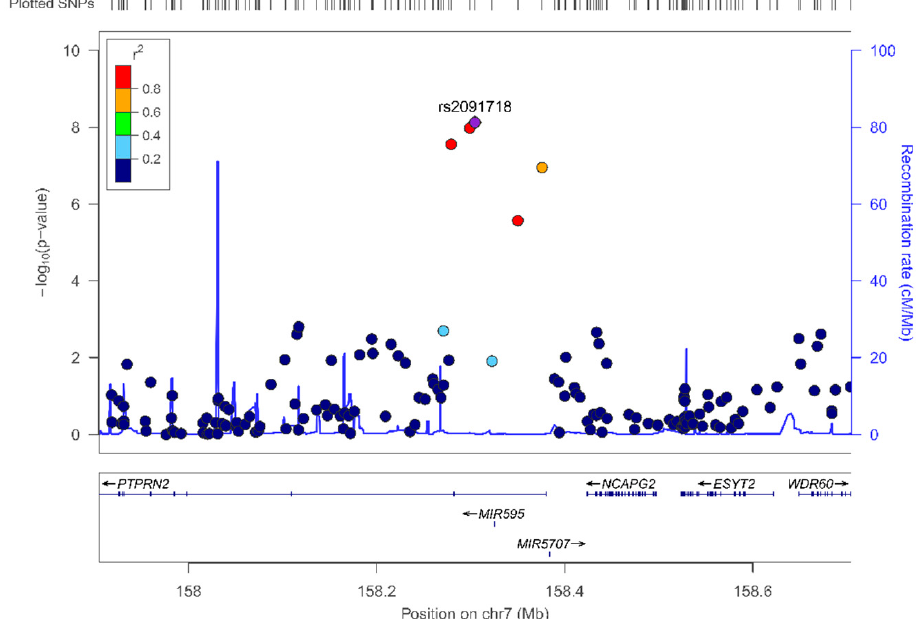
Figure 3. Regional plot for the lead-SNP rs2091718, located in the protein tyrosine phosphatase receptor type N2 (PTPRN2) gene, on chromosome 7, for sweet taste preference (as a dichotomous variable). p -values obtained in the logistic regression model adjusted for sex and age.